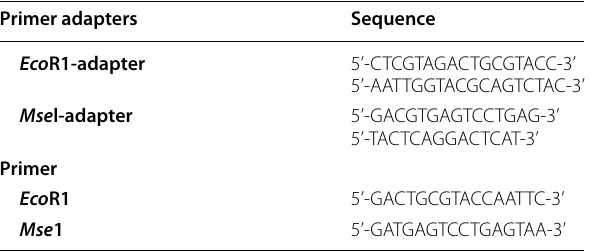
Table 1 Sequences of the adapters and the selective primers used in AFLP analysis Primer